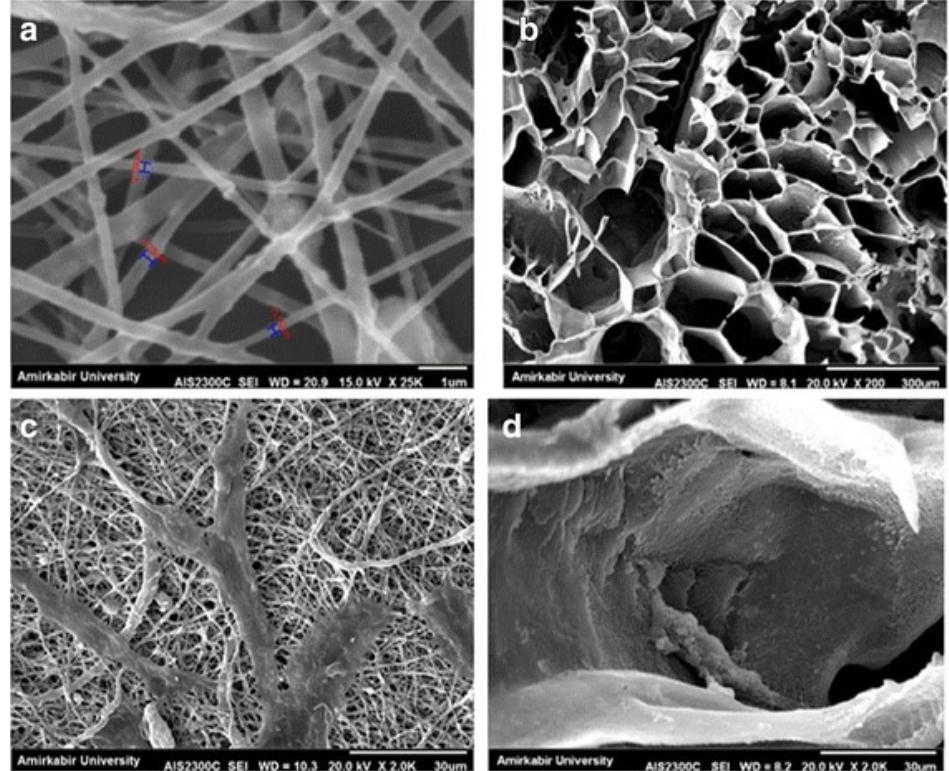
Figure 3. SEM images: ( a ) 1 μ m; electrospinning, ( b ) 300 μ m; freeze-drying, obtained from the surface of the synthesized scaffolds, ( c ) cell attachment, 30 μ m; electrospinning, ( d ) 30 μ m; freeze-drying [49]. Reprint with permission from PMC.